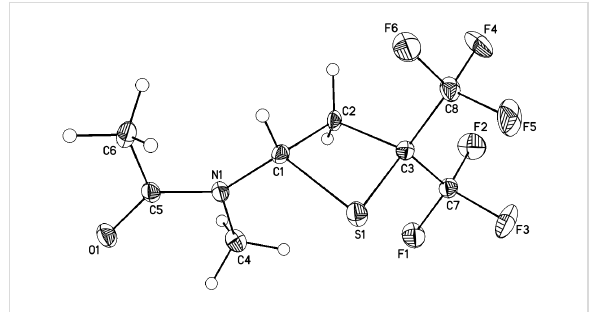
Figure 1: Crystal structure of 3b with thermal ellipsoids drawn at the 30% probability